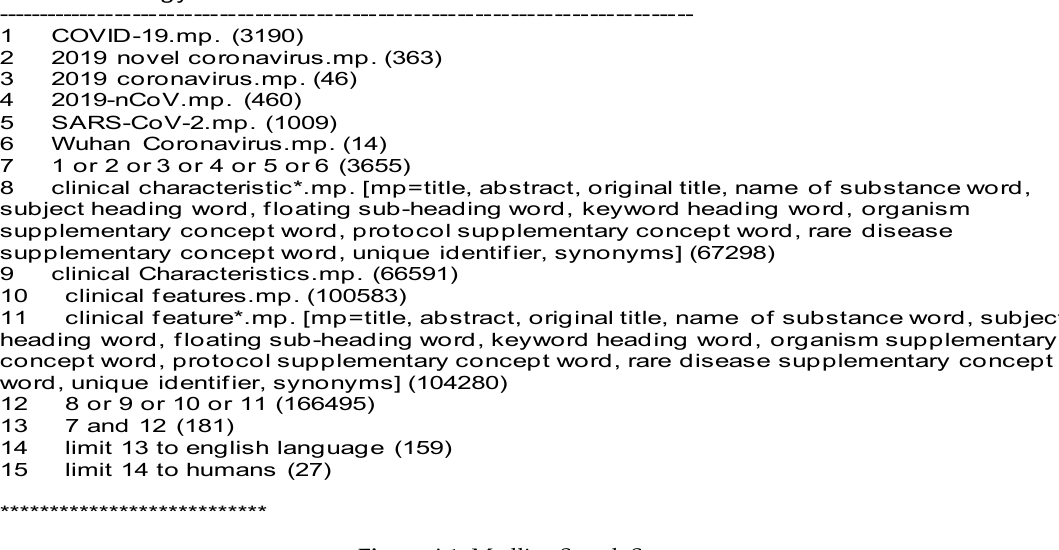
Figure A1. Medline Search Strategy.